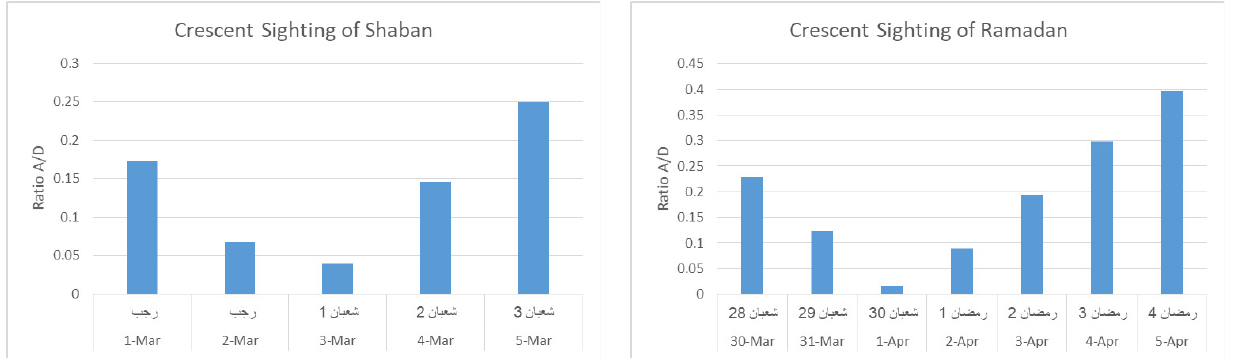
Figure 4. The model’s crescent visibility of Shaban 1443 H.